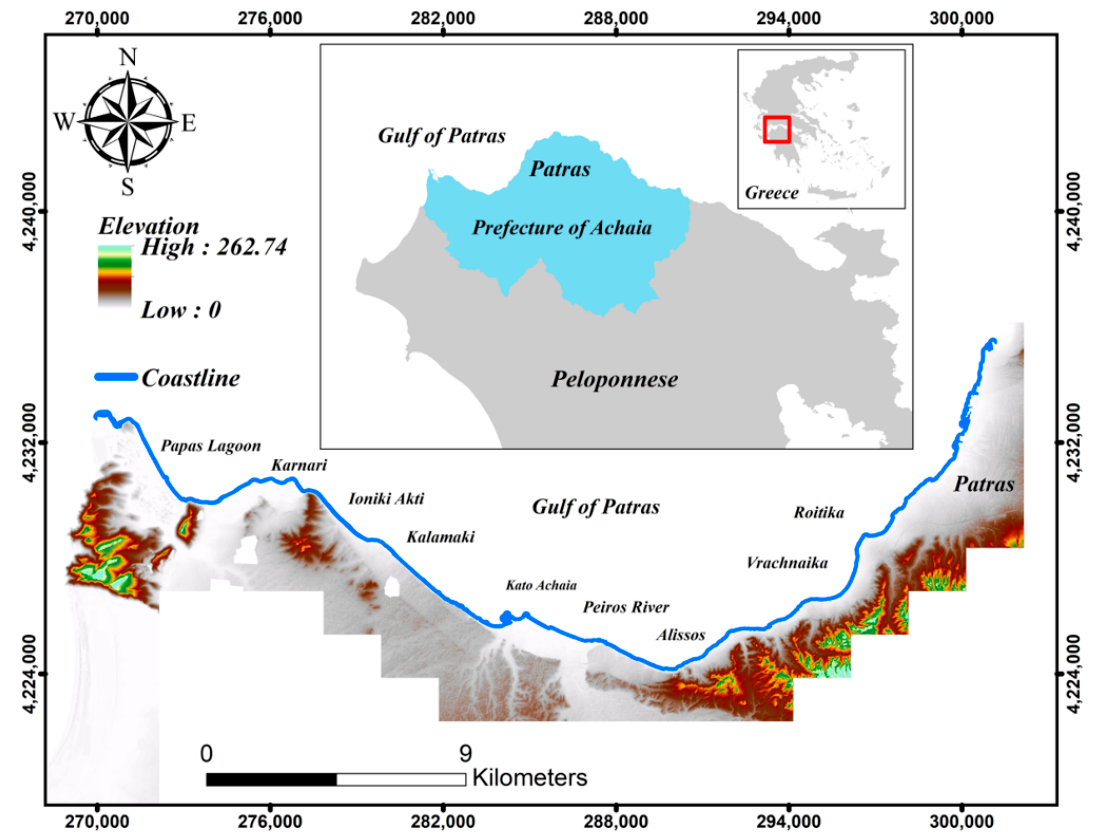
Figure 1. Map of the investigation area with the blue line representing the inspected south coastline of the Gulf of Patras. The geodetic coordinates of the map correspond to the Greek Geodetic Refer- ence System—GGRS87.